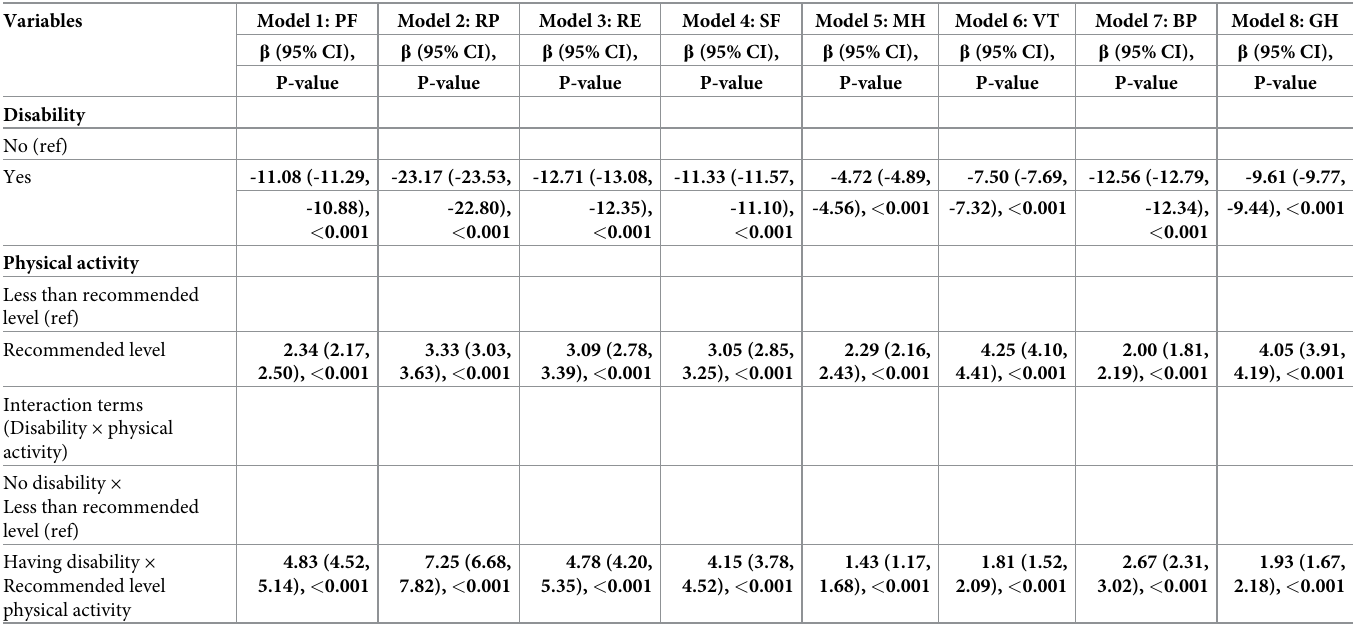
Table 5. The relationship between disability and physical activity with the dimensions of the SF-36, random-effects GLS